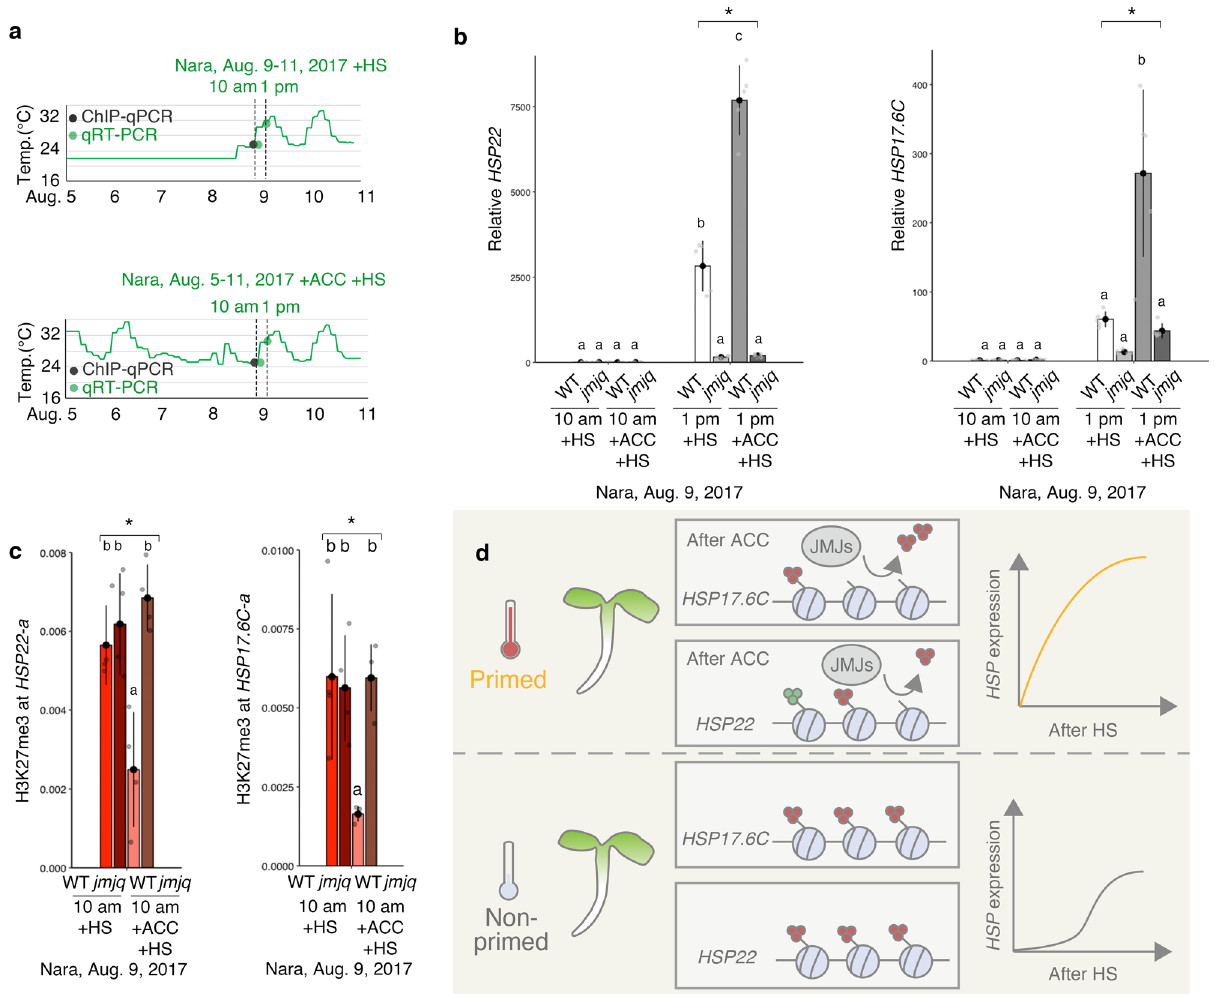
Fig. 6 JUMONJI demethylases are required for the removal of H3K27me3 histone modi fi cations from heat-memory genes under fl uctuating temperature conditions. a Schematic representation of the temperature conditions used. Colored dots indicate the times of different assays: qRT-PCR, red; ChIP-qPCR, gray. Upper, basal thermotolerance condition ( + HS); Lower, heat-stress memory condition ( + ACC + HS). b Gene expression levels of HSP22 and HSP17.6C in the wild type and jmjq grown under the Nara conditions. Gray dots represent the expression levels of individual samples. One-way ANOVA test; * p < 0.05. Letters above bars indicate signi fi cant differences based on a post-hoc Tukey HSD test ( p < 0.05). c H3K27me3 levels at HSP22 and HSP17.6C in the wild type and jmjq grown under the Nara conditions. One-way ANOVA test; * p < 0.05. Different letters above bars indicate signi fi cant differences based on a post-hoc Tukey HSD test ( p < 0.05). d Current model of JUMONJI-mediated heat acclimation. Upon exposure to a triggering heat, plants are acclimatized. Three red and green circles represent H3K27me3 and H3K4me3, respectively. JMJ proteins keep H3K27me3 at lower levels on HSP17.6C and HSP22 . The primed plants respond to recurring heat faster or more strongly than non-primed plants